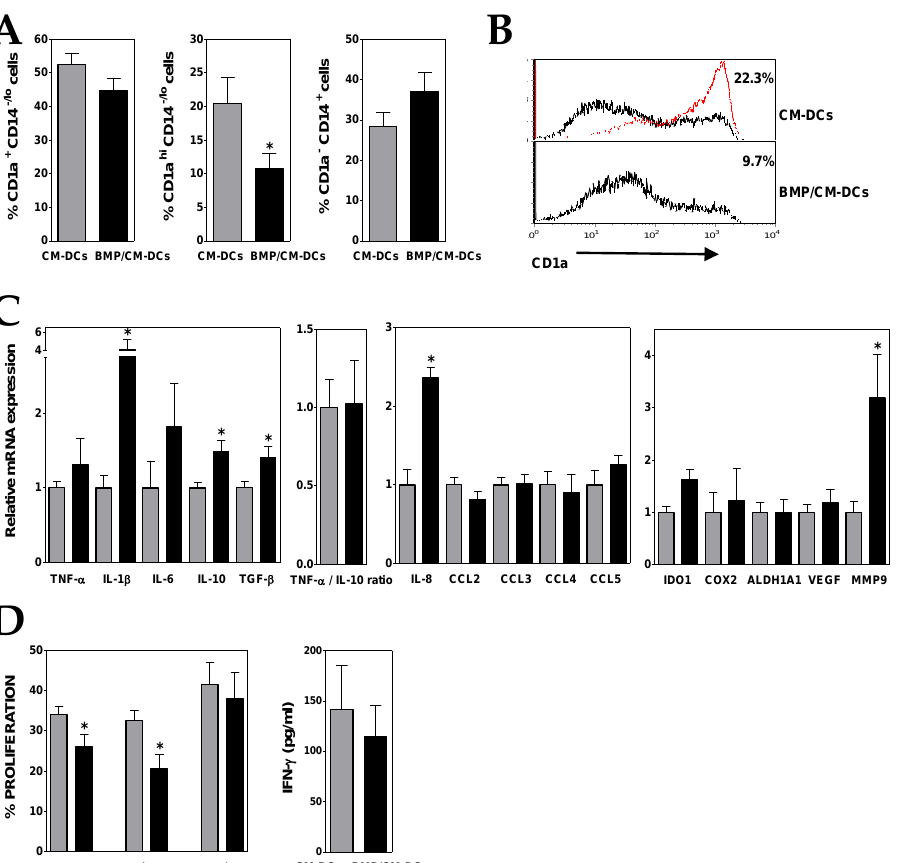
Figure 2. BMP4-overexpressing ALL cells exhibit a higher capacity to generate immunosuppressive DCs. ( A ) Percentages of CD1a + CD14 − / lo , CD1a hi CD14 − / lo and CD1a − CD14 + cells recovered DCs. ( A ) Percentages of CD1a + CD14 -/lo , CD1a hi CD14 -/lo and CD1a - CD14 + cells recovered after 5–6 days